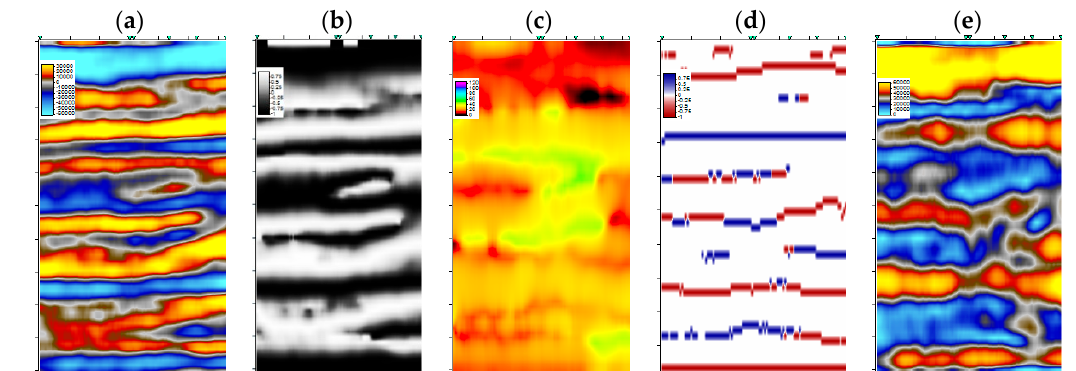
Figure 7. ( a ) The most significant components of a seismic trace; ( b ) Raw seismic data (Wiggle traces) and acoustic impedance inversion (color attribute) in the location of one of the studied wells overlain by the P-wave velocity from logging curve.